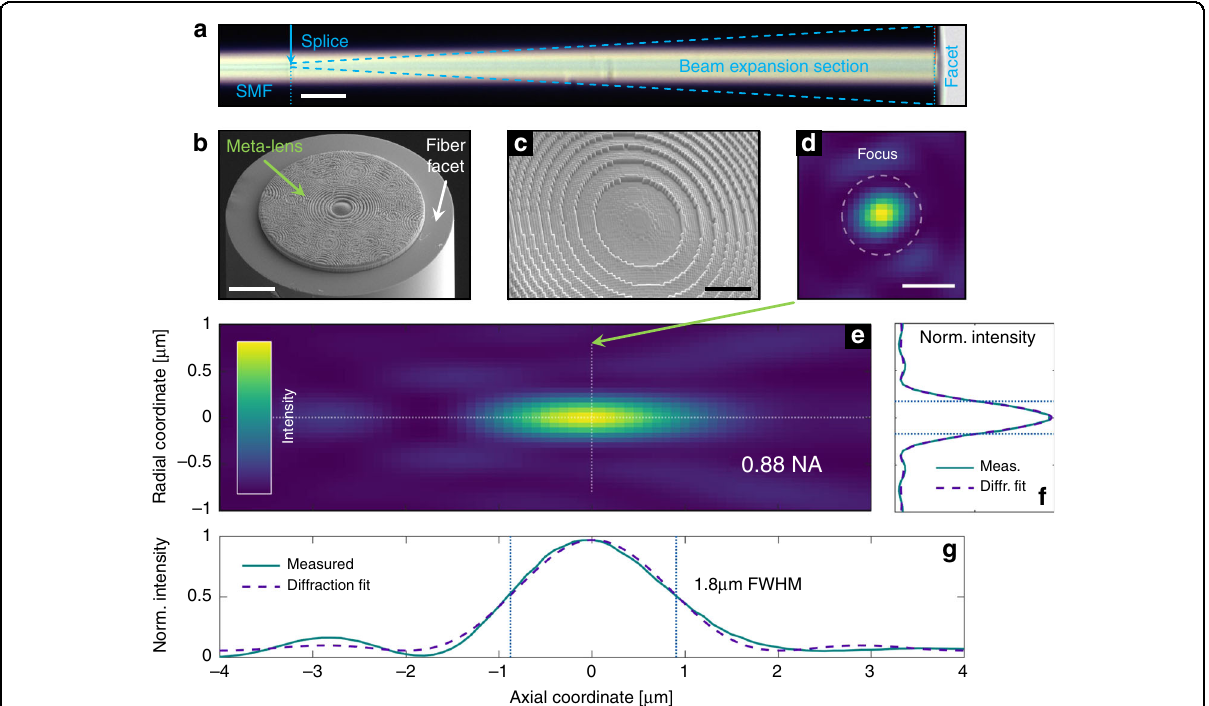
Fig. 3 Measured focusing performance of the implemented UNM-enhanced meta- fi bre (sample 2, λ 0 = 660 nm in water). a Microscope image of a functionalized meta- fi bre consisting of a single-mode fi bre and spliced beam expansion section (scale bar 50 µm). b , c Scanning electron micrographs of an example implemented device (scale bars at 25 µm and 10 µm, respectively). d Measured cross-section of the beam taken at the focal plane ( z = 0, scale bar: 500 nm). The dashed circle describes the width of a fi tted Airy function. e Axial stack for measured beam cross-sections in cylindrical coordinates obtained by transforming each 2D image into radial symmetry via azimuthal averaging (note that the scale of both axes is the same as that in ( d ) and ( g )). f Radial and ( g ) axial intensity pro fi les (solid) along the symmetry axes of the focus, with the dashed lines showing the corresponding fi ts. In all contour plots, the colour scale ranges linearly from zero (dark blue) to unity